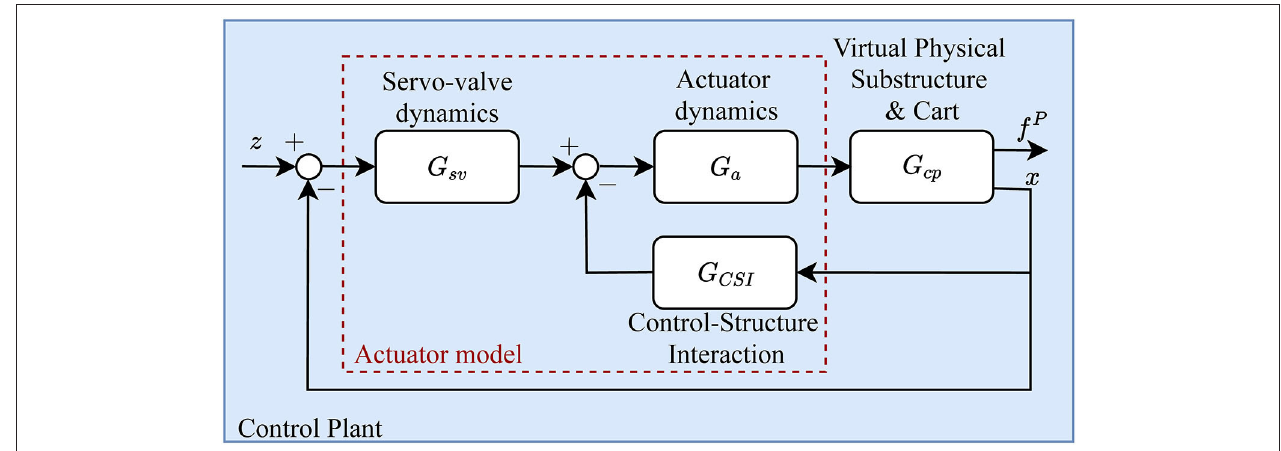
FIGURE 4 | Block diagram of the control plant in